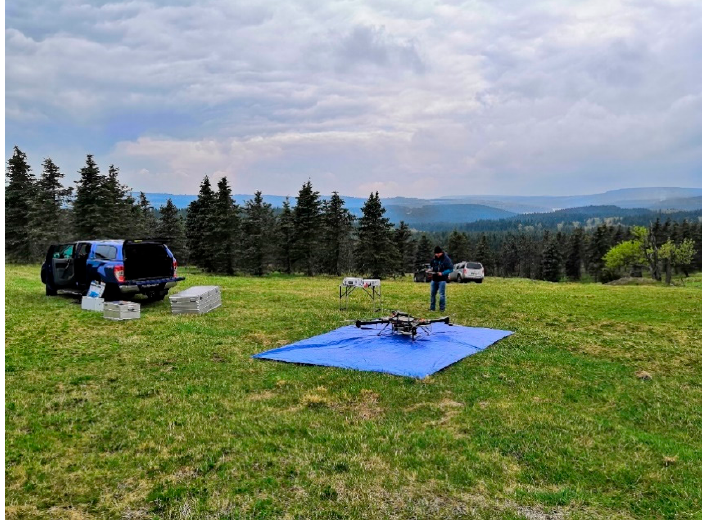
Figure 2. The UAS VUX-SYS setup and pilot before takeoff during the spring data acquisition (7 May Figure 2. TheUASVUX-SYSsetupandpilotbeforetakeoffduringthespringdataacquisition(7 May 2019).